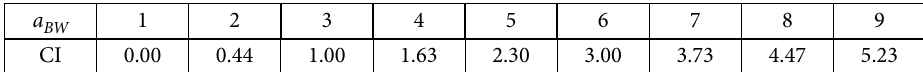
Table 2. Values of